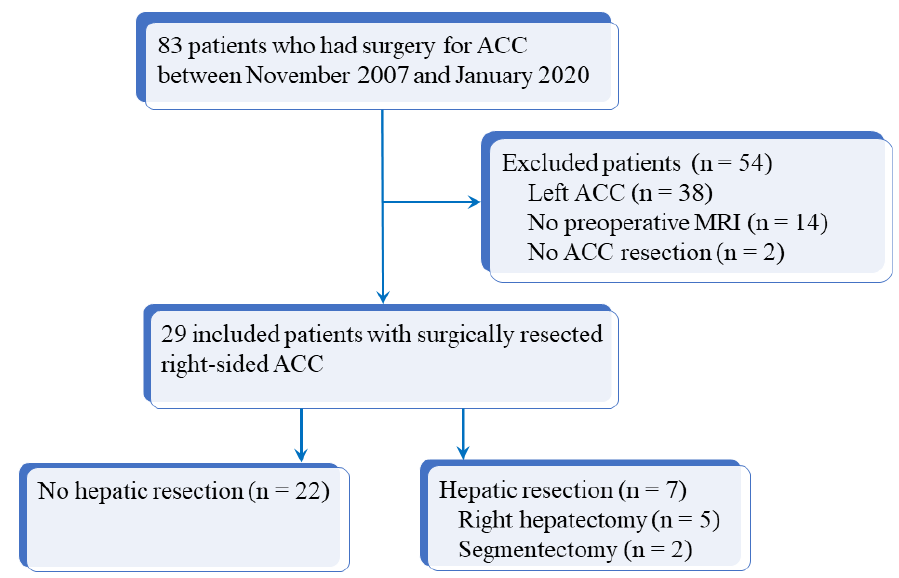
Figure 1. Flow chart of the study. ACC: adrenocortical carcinoma; MRI: magnetic resonance imaging. Table 1. Initial characteristics of 29 patients with right-sided adrenocortical carcinoma.